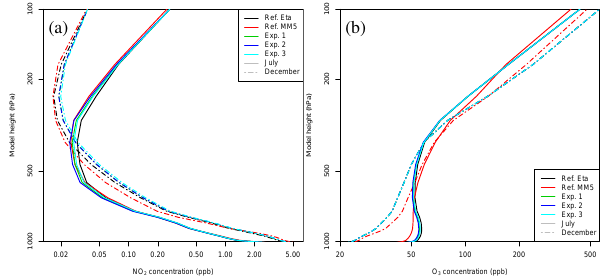
Fig. 12. Modelled concentration profiles, averaged over region CE (Fig. 1b), for July and December and for eachofthefivesimulations.